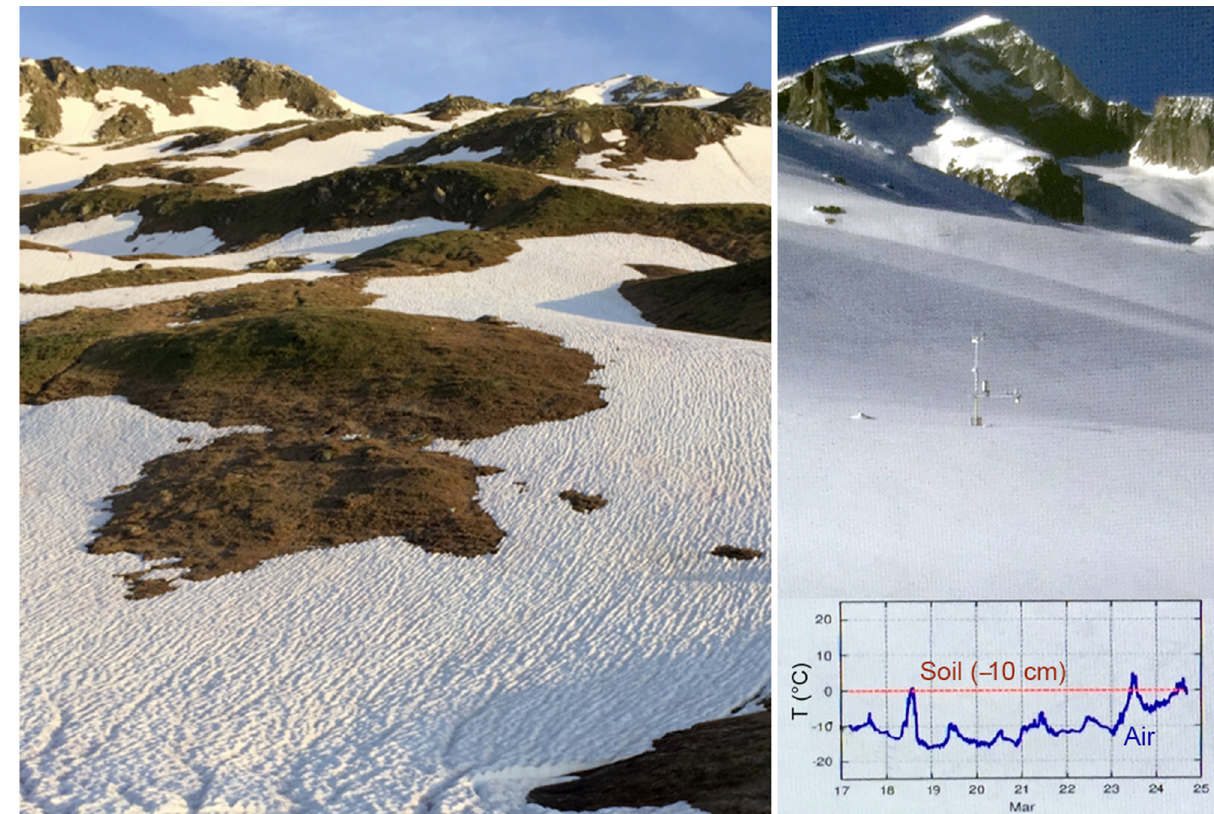
Figure 2. Left : Snowpack determines the length of the growing season (photo taken on 15 June 2018 at 2440 m in the Swiss Alps). Right : Snow cover decouples life conditions from ambient atmospheric conditions and ensures often non-freezing conditions during winter (screen shot of the webcam at the same location, viewing a location slightly to the right of the same place, but on 24 March 2021).